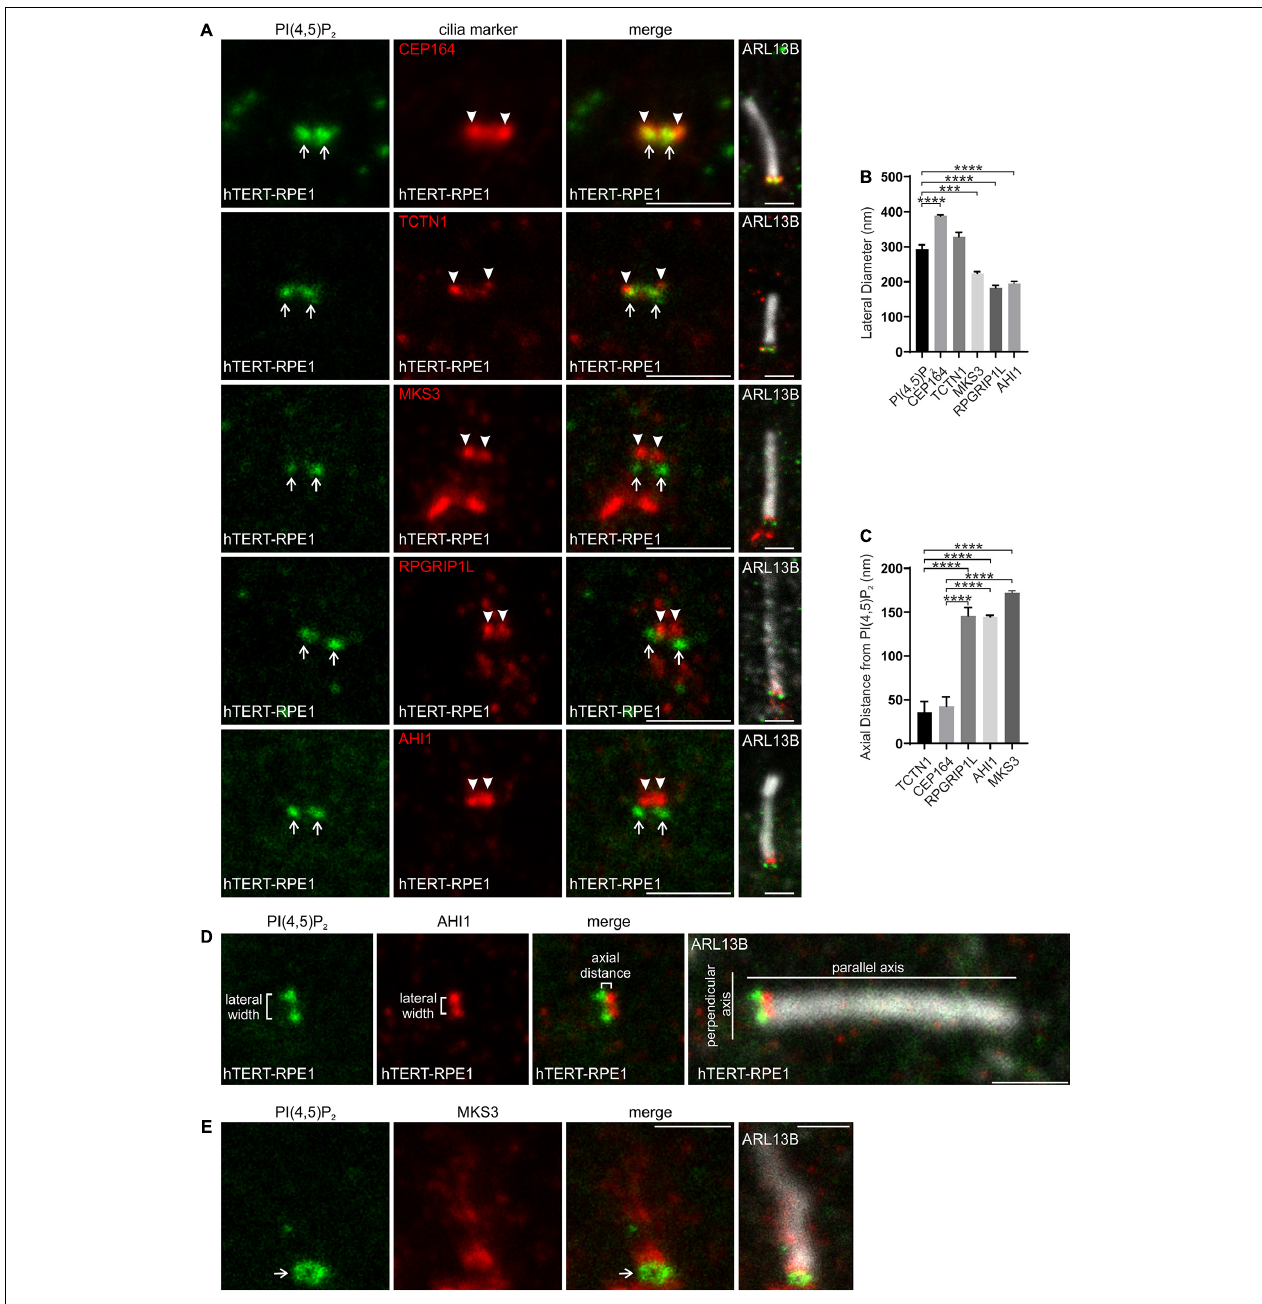
FIGURE 2 | PI(4,5)P 2 localizes to a specific subdomain of the transition zone. (A) Ciliated hTERT-RPE1 cells were immunostained with PI(4,5)P 2 (green), ARL13B (grayscale) and CEP164, TCTN1, MKS3, RPGRIP1L or AHI1 (red) antibodies and imaged by STED microscopy (confocal resolution image of the ARL13B stained axoneme is shown). Right panels show merged image at lower magnification. Arrows indicate transition zone PI(4,5)P 2 signals, arrow heads indicate transition zone protein localization, bar indicates 1 µ m. (B) Graph shows the lateral diameter between the highest intensity points of the PI(4,5)P 2 or cilia protein marker puncta perpendicular to the plane of the axoneme. Bars represent mean ± SEM, n = 3 independent experiments, ≥ 30 cilia imaged per experiment and all cilia with two distinct PI(4,5)P 2 or cilia marker protein puncta measured, statistical significance was determined using one-way ANOVA ( p < 0.0001) followed by Tukey’s post hoc test *** p < 0.001, **** p < 0.0001. (C) Graph shows the axial distance between the highest intensity point of the PI(4,5)P 2 signal and each cilia marker protein signal parallel to the plane of the axoneme. Bars represent mean ± SEM, n = 3 independent experiments, ≥ 30 cilia imaged per experiment and all cilia with distinct PI(4,5)P 2 or cilia marker protein puncta measured, statistical significance was determined using one-way ANOVA ( p < 0.0001) followed by Tukey’s post hoc test, **** p < 0.0001. (D) Representative image showing the method used for lateral diameter and axial distance measurements, bar indicates 1 µ m. (E) Ciliated hTERT-RPE1 cells were immunostained with PI(4,5)P 2 (green), MKS3 (red) and ARL13B (grayscale) antibodies and imaged by STED microscopy (confocal resolution image of the ARL13B stained axoneme is shown). Right panel shows merged image at lower magnification. Arrow indicates ring shaped transition zone PI(4,5)P 2 morphology, bar indicates 1 µ